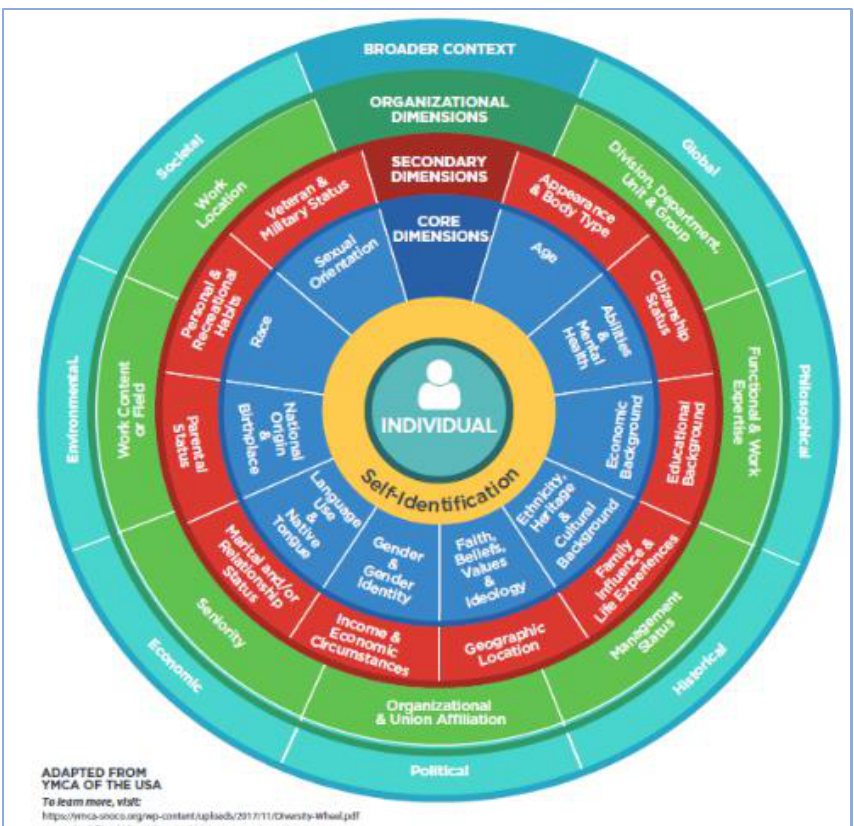
Figure 1. Dimensions of Diversity (Fields, 2019; YMCA of the USA,